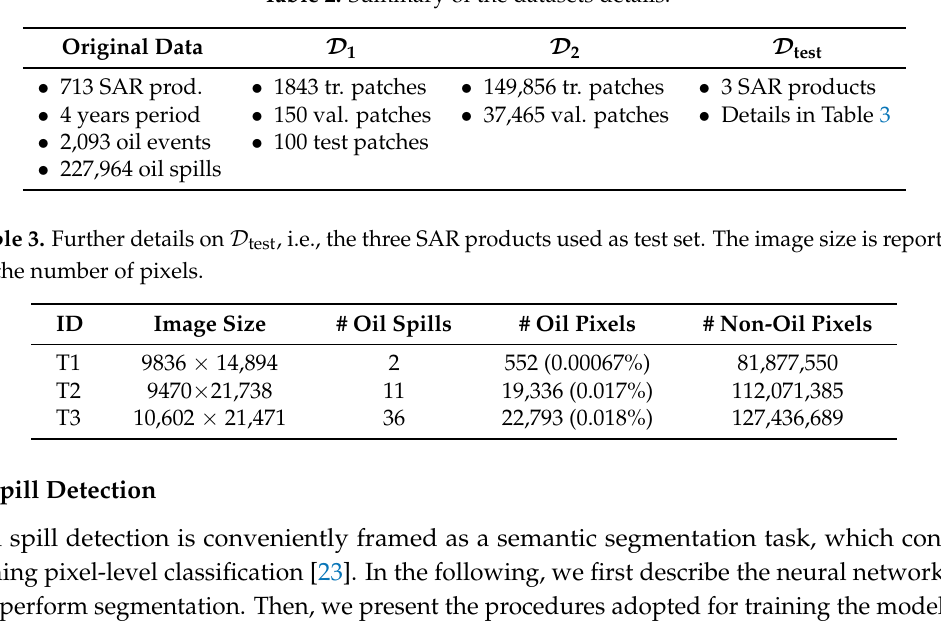
Table 2. Summary of the datasets details.